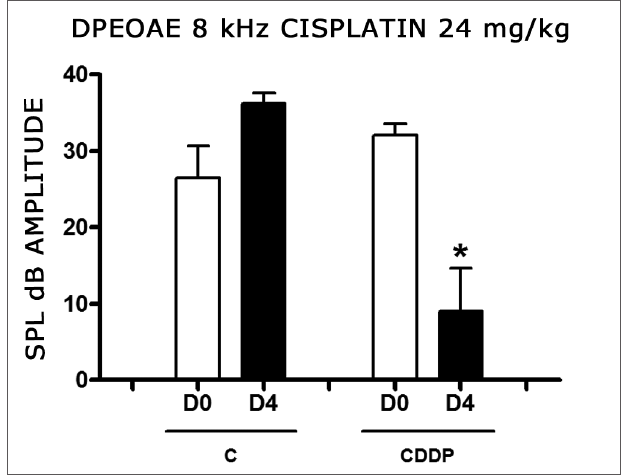
Figure 2. Graph showing DPEOAE amplitudes expressed as mean and error deviation of the average values in days D0 and D4, in groups 3 and 4 at the frequency of 8 kHz. The asterisk represents statistical significance. CDDP = cisplatin; C = control. T Test: * p = 0.0459 (D4 x D0 CDDP).